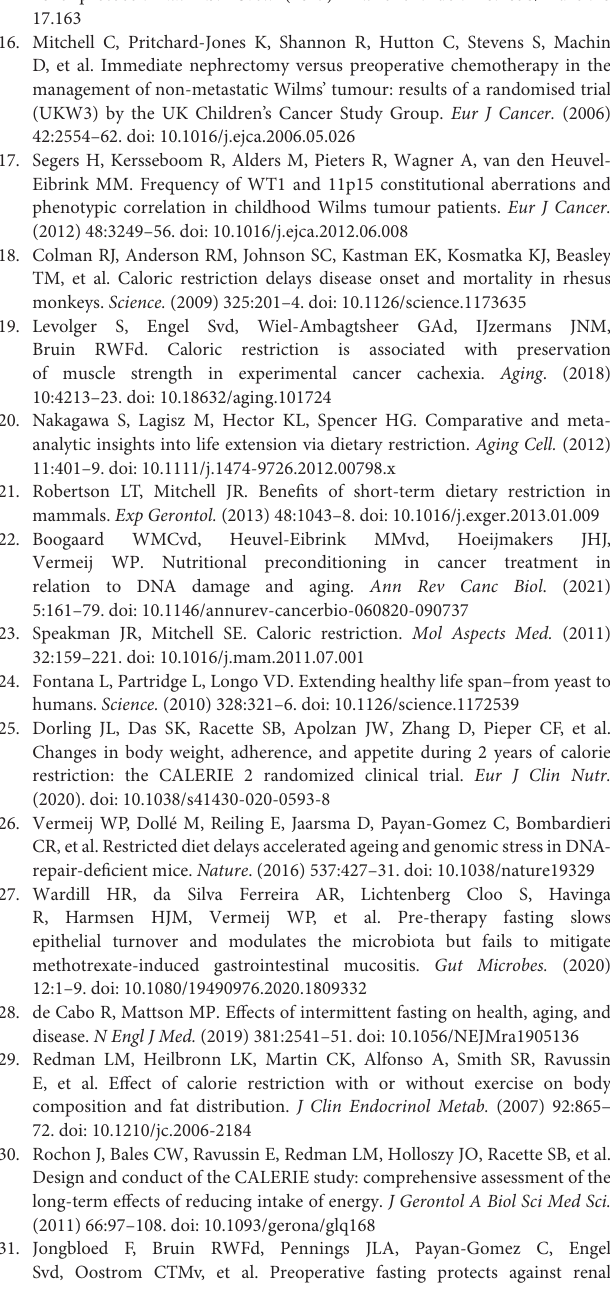
Supplementary Figure 1 | Schematic overview of the FIURTT study. Supplementary Figure 2 | Survival graphic from the fasting test from van Veen et al.